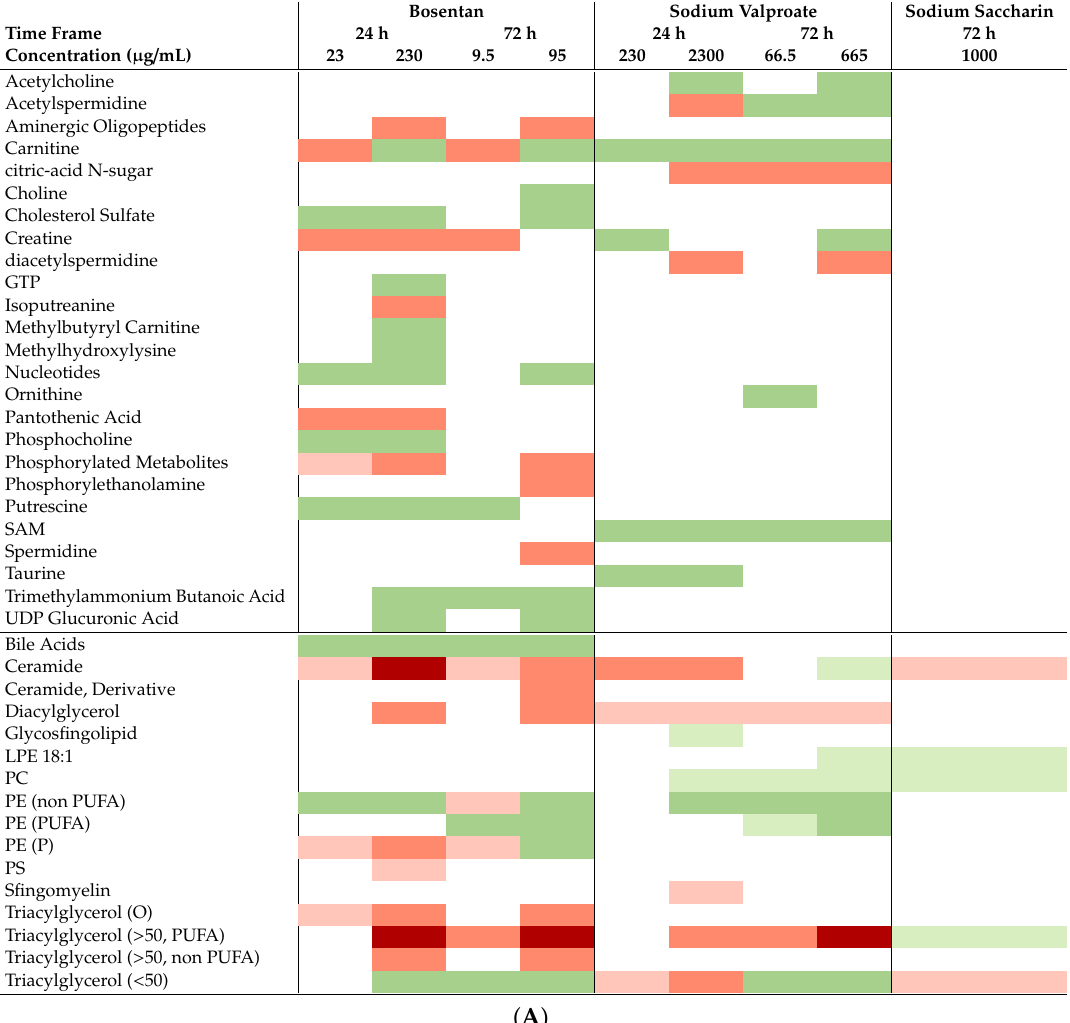
Table 3. Heat map for the endogenous markers of toxicity for hepatotoxicants inducing steatosis (sodium valproate) [8] and cholestasis (bosentan) [29] showing their up- (red) or down-regulation (green) in comparison to a negative control group (sodium saccharin). Common alterations indicate the importance of the use of non-hepatotoxic reference compounds as a negative control to prevent an exposure bias, especially in the lipidomics